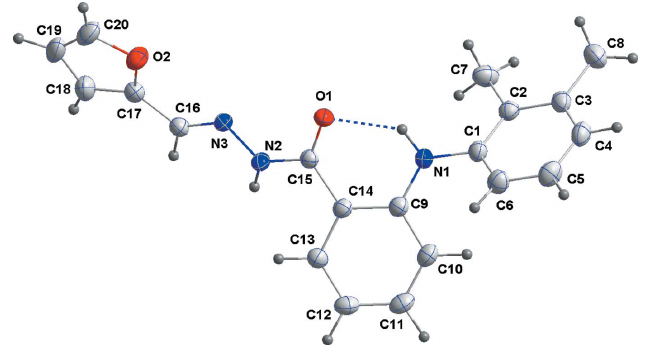
Figure 1 The molecule of (I) with atom-labeling scheme and displacement ellipsoids drawn at the 50% probability level. The intramolecular N— H (cid:2)(cid:2)(cid:2) O hydrogen bond is shown as a dashed line.